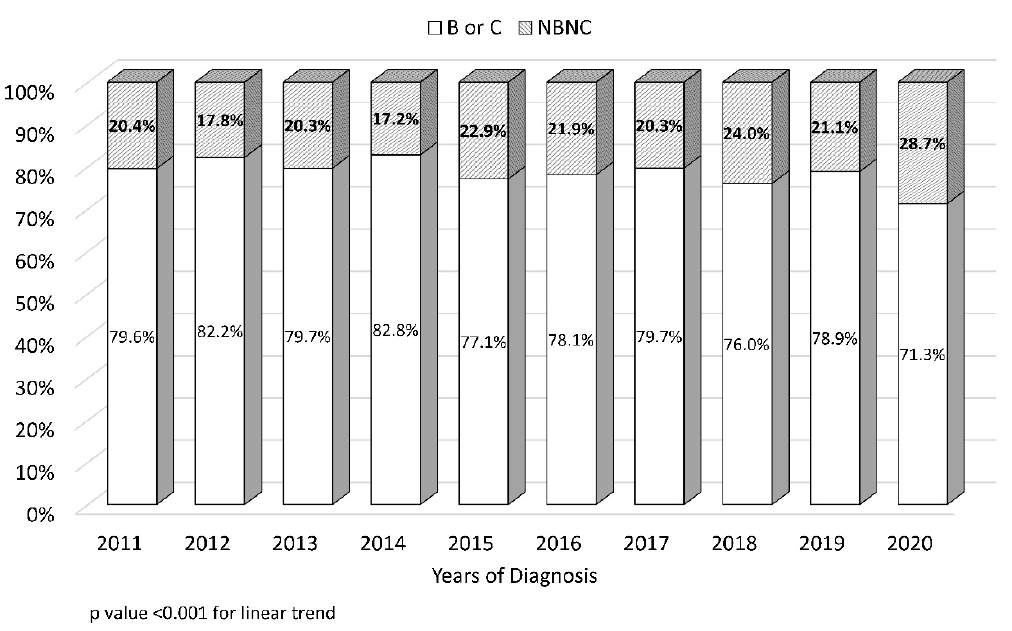
Figure 3. Trend in nonviral etiology (i.e., patients negative for both hepatitis B and C viruses) at the time of hepatocellular carcinoma diagnosis.